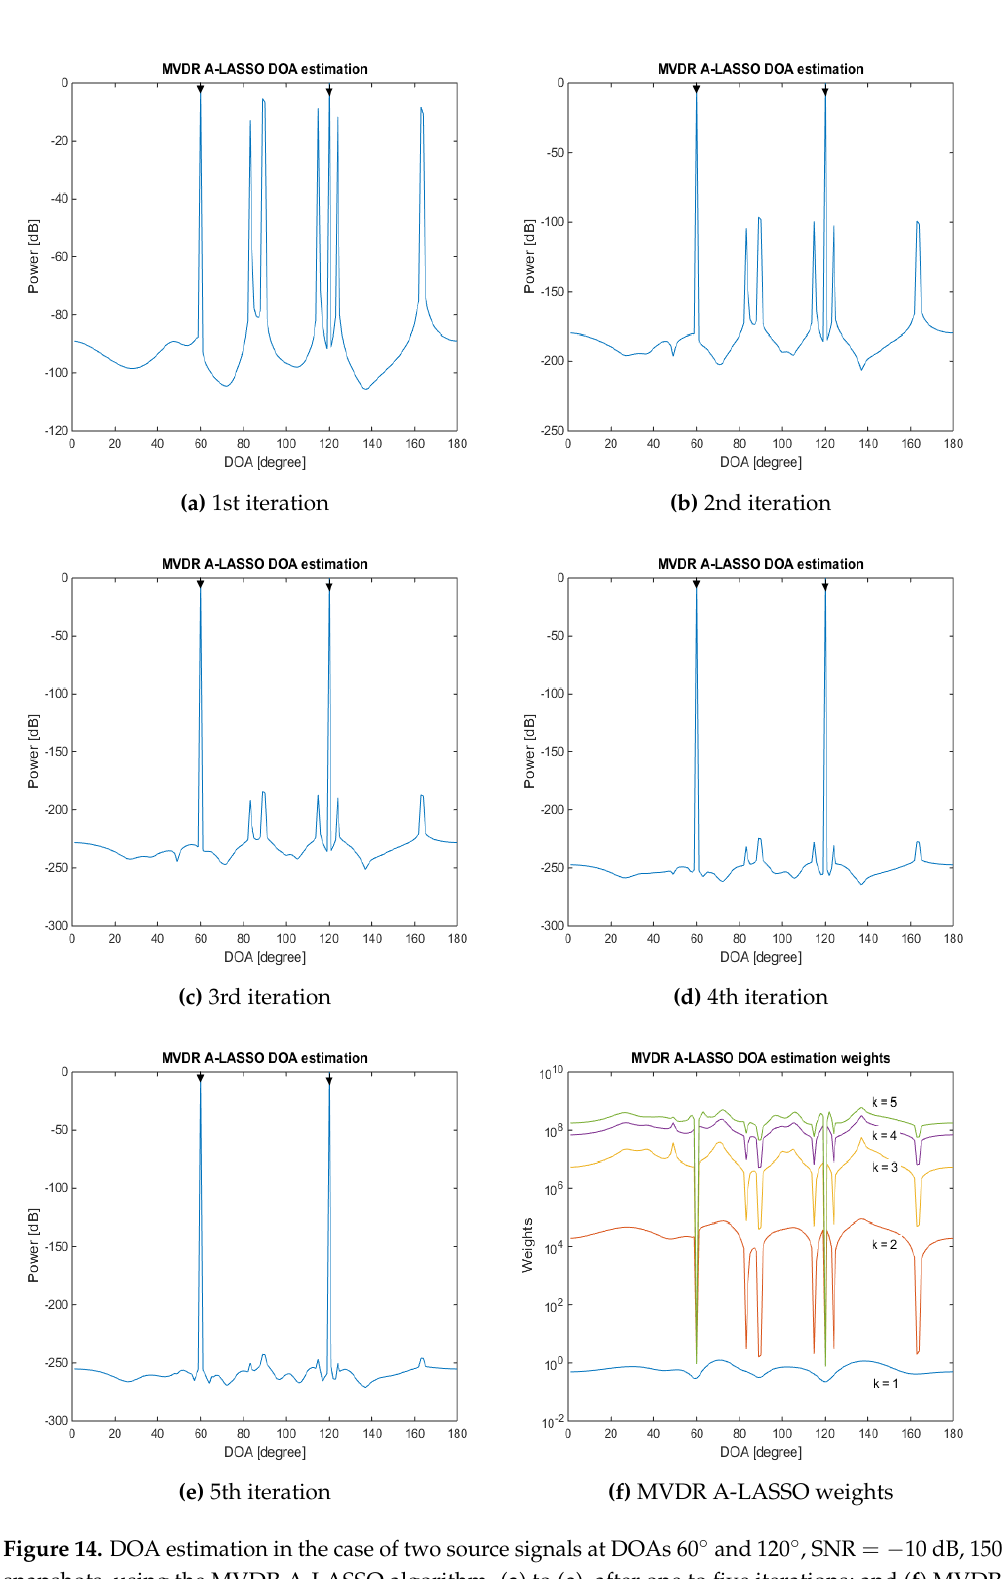
Figure 14. DOA estimation in the case of two source signals at DOAs 60 ◦ and 120 ◦ , SNR = − 10 dB, 150 snapshots, using the MVDR A-LASSO algorithm. ( a ) to ( e ), after one to five iterations; and ( f ) MVDR A-LASSO weights as the number of iterations k